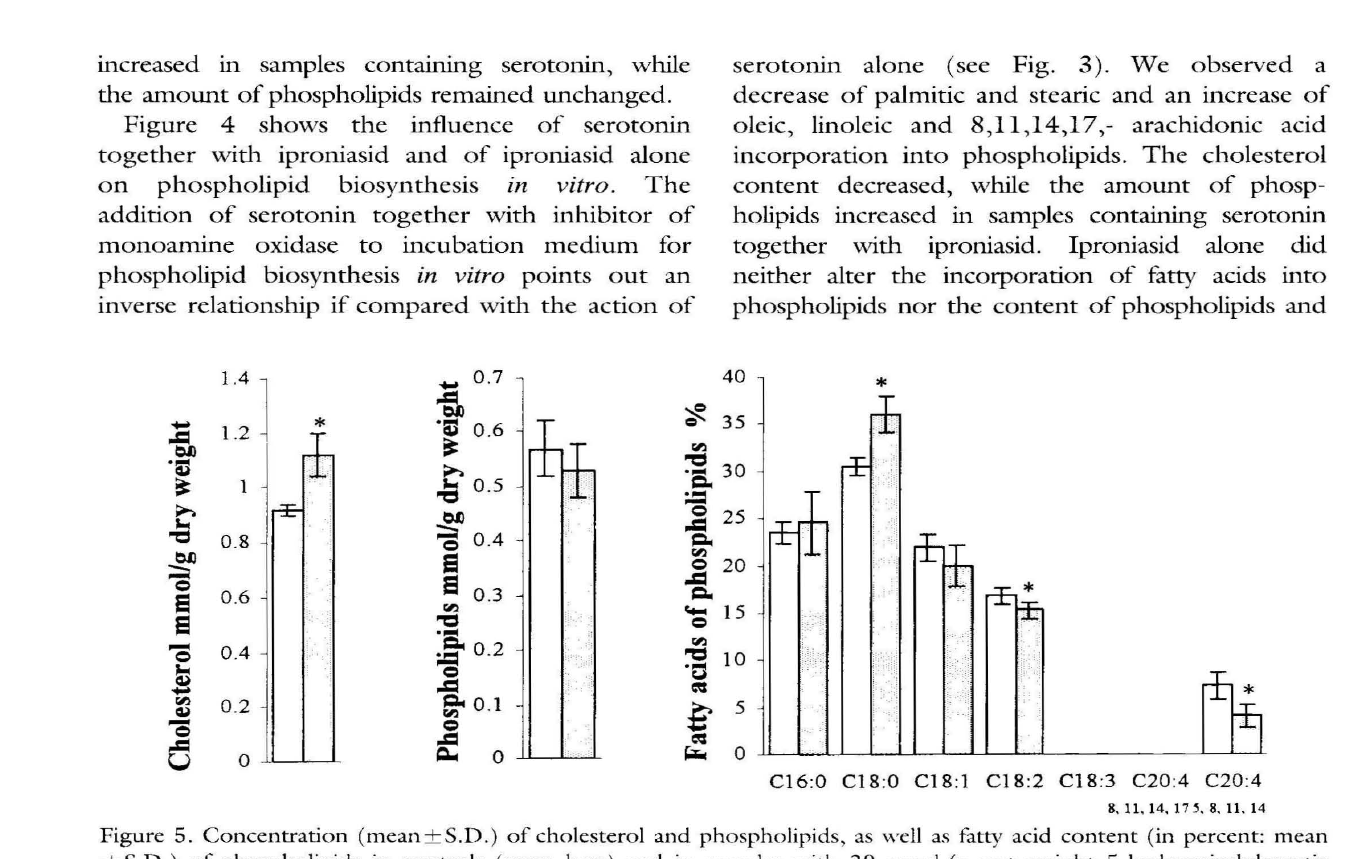
Figure 5. Concentration (mean ± S.D.) of cholesterol and phospholipids, as well as fatty acid content (in percent: mean ± S.D .) of phospholipids in controls (opcn bars) and in samples with 20 nmoljg wet weight 5-hydroxyindoleacetic acid (dottcd bars). Samples of rat liver tissue homogenates were used to test tor phospholipid biosynthesis in vitro. In cubation medium: Krebs-Ringer-phosphate buffer, containing 0.3% albumin (pH=7.4), fatty acid mixture and glycerol. Samples were incubated twice fo r 4 h at 37"C. *T he changc:s arc: statistically significant (p < 0.05-p < 0.001). Pteridines/ Vol. 9 / No.